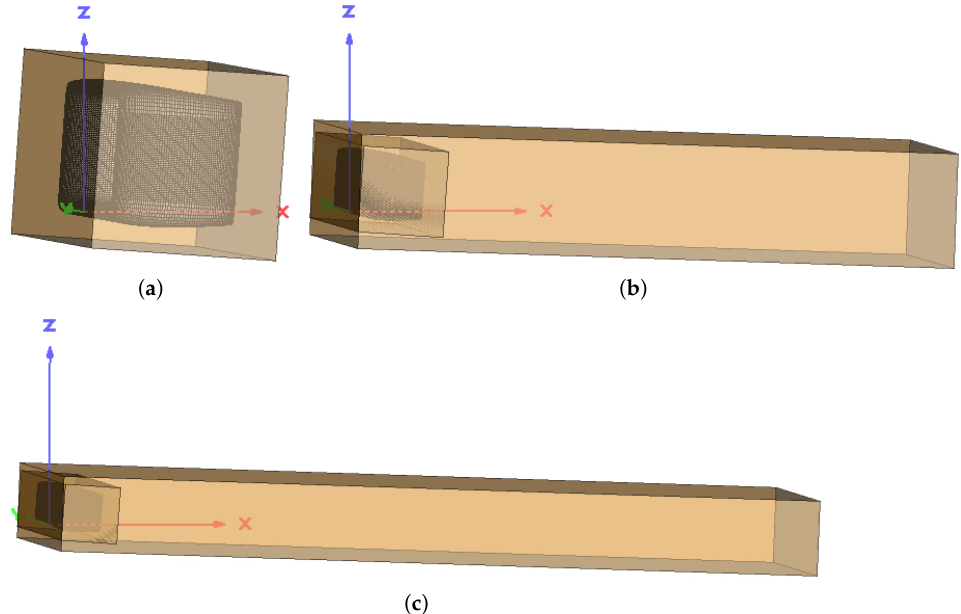
Figure 7. Mesh refinement: ( a ) low-resolution case ≈ 28 M cells; ( b ) medium-resolution case ≈ 51 M cells; ( c ) high-resolution ≈ 83 M cells